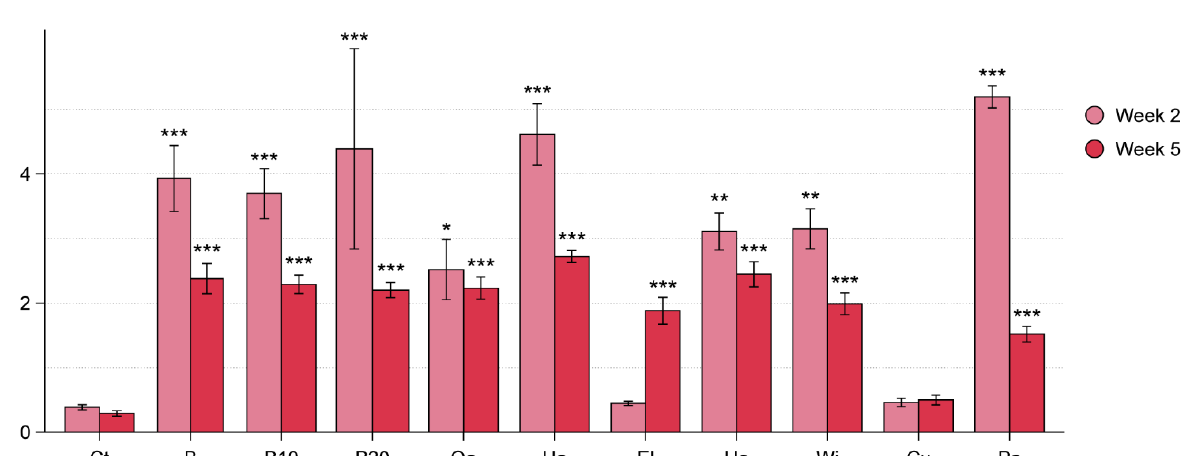
Figure 3. Performance of R. solani on 14 types of wood sawdust and paper pulp. The area of the substrates colonized by the mycelium of R. solani is shown on the x axis (mean ± se , n = 5), whereas